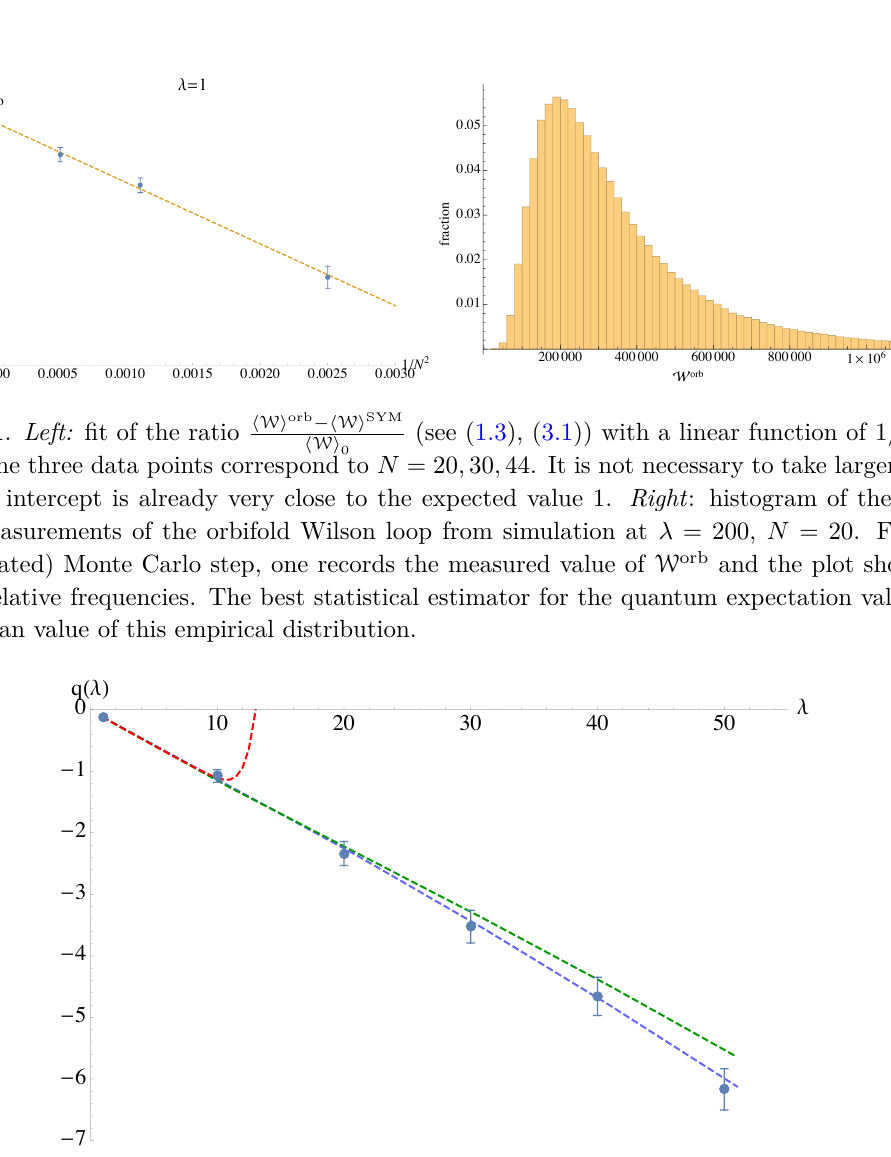
Figure 2 . Borel-Padé resummation of the perturbative expansion of q orb ( λ ) . The red line is the